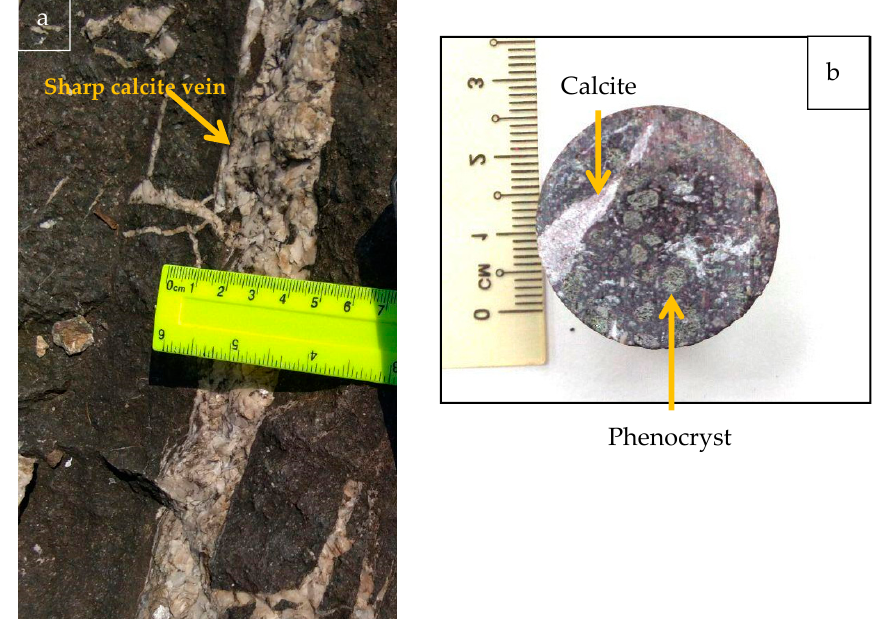
Figure 2. Calcite veins ( a ) and mafic phenocrysts ( b ) from the Segamat basalt outcrop.